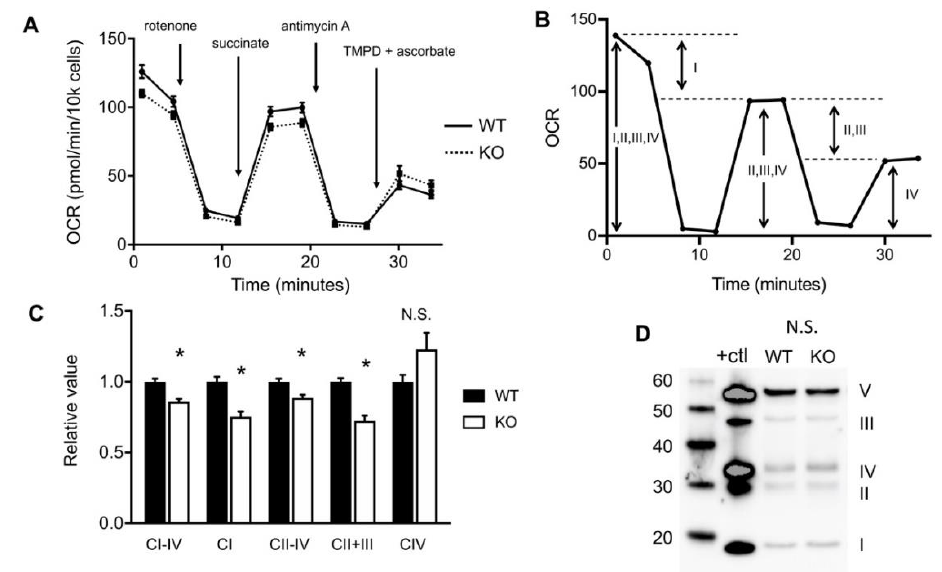
Figure 2. HO-1 knockout cells have reduced electron flow across the electron transport chain ETC. ( A ), Representative trace of the electron flow assay with injection strategy, measured with the Seahorse. ( B ), Illustration of parameters used to calculate the activities of each complex. ( C ), Relative activities of WT and KO ETC complexes. ( D ), Western blot of WT and KO cells using a five-antibody cocktail, detecting one protein from each ETC Complex. A positive control (+ctl) was provided by the manufacturer. Molecular weight ladder (20–60 kDa) is shown. OCR, oxygen consumption rate. * p < 0.05 vs. WT. Error bars are SEM.